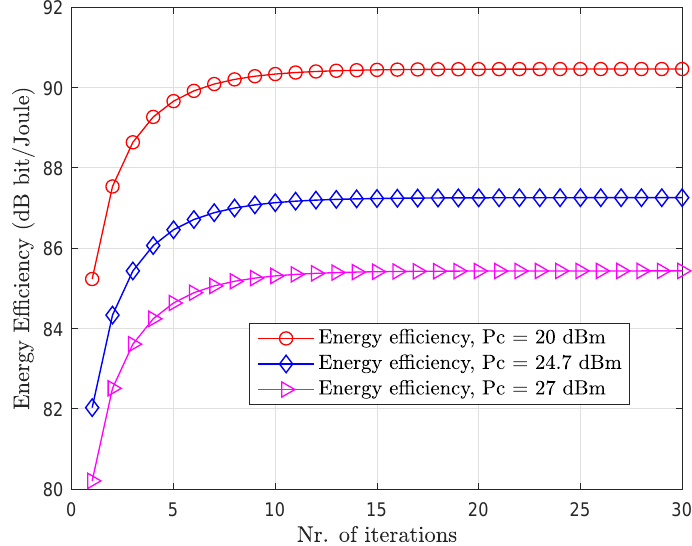
Figure 3. Energy efficiency versus number of iterations with M = 10 and K = 10, for different circuit power consumption P c